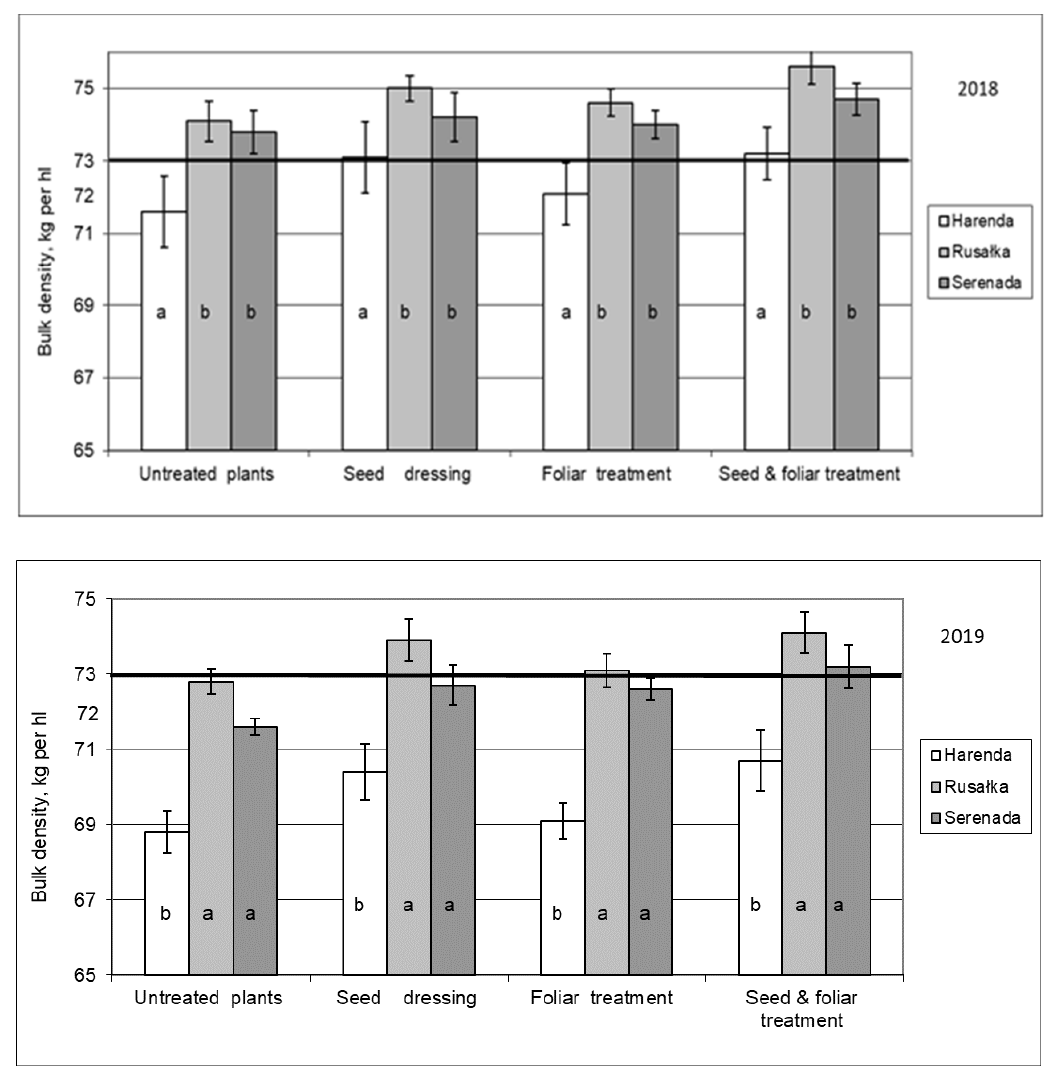
Figure 1. E ff ect of Si application method on bulk density of wheat cultivars in 2018 and 2019. Values followed by the same letter are not statistically di ff erent at p < 0.05. The bold line indicates the bulk density guide value (73 kg per hL) for wheat grain.